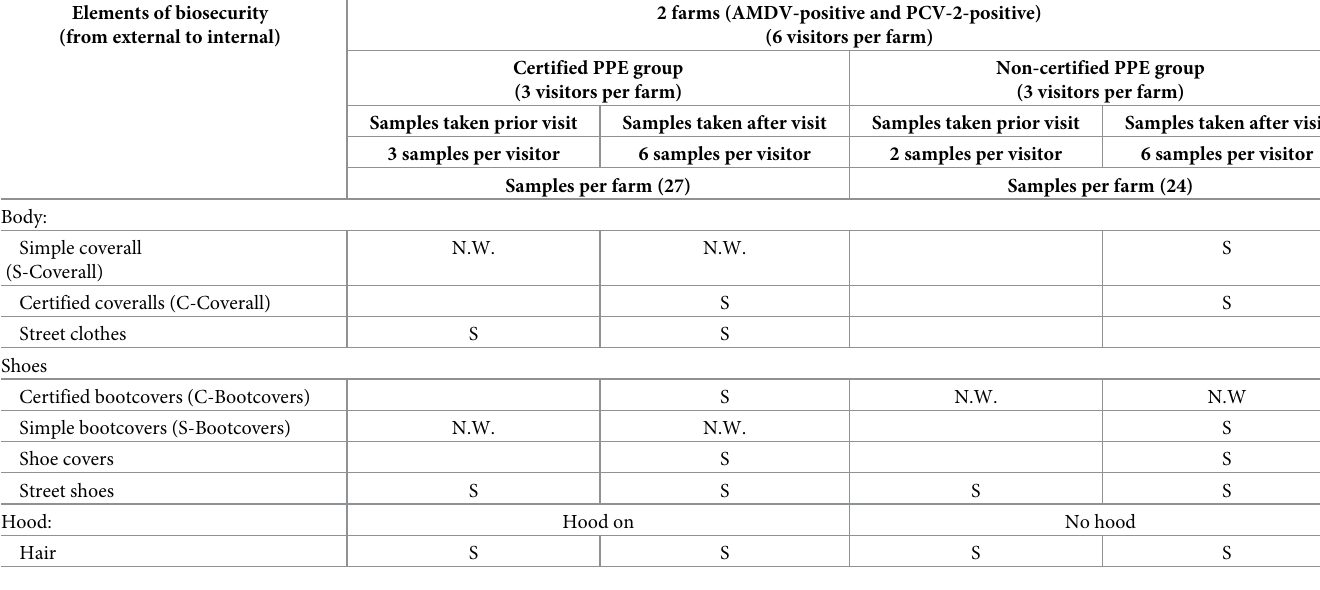
Table 1. Samples taken of each element of biosecurity prior and after visit. Elements of biosecurity (from external to